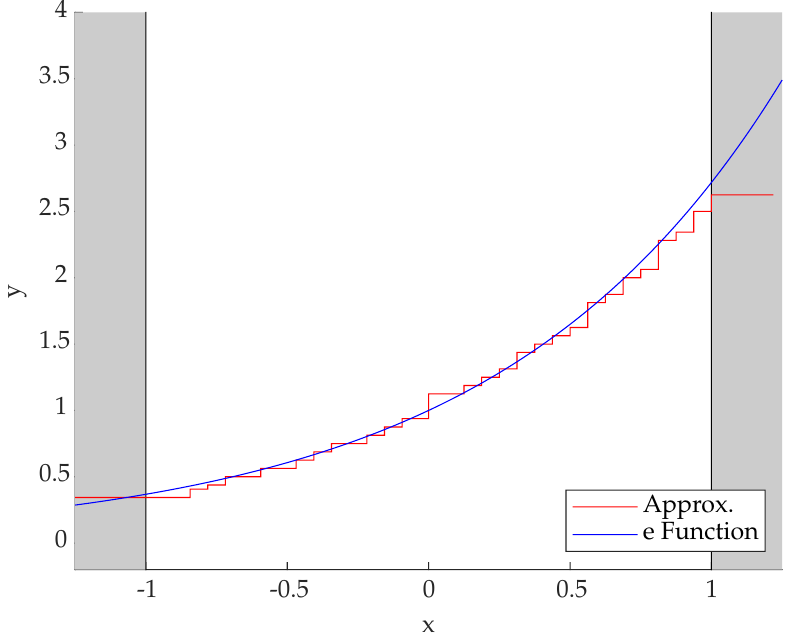
Figure 4. Plot of the mathematical e-function ( blue ) as well as the hardware-implemented approxi- mation ( purple ). The algorithm is used in the range from